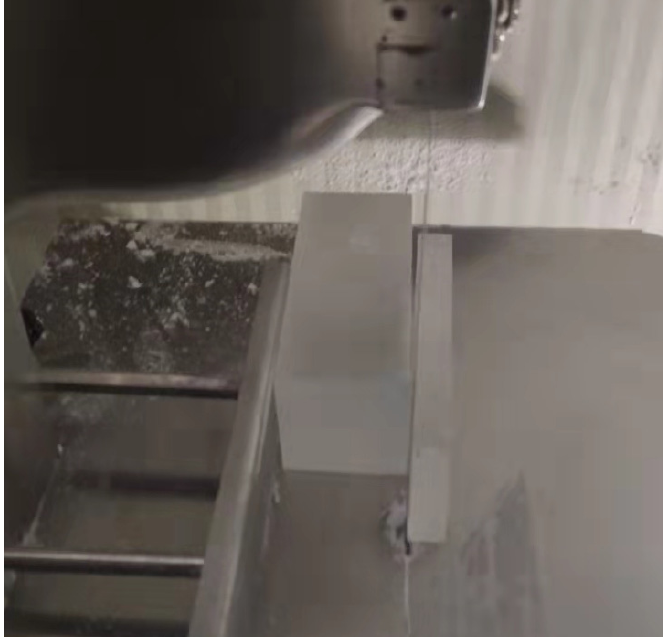
Figure 2. Test sample preparation.